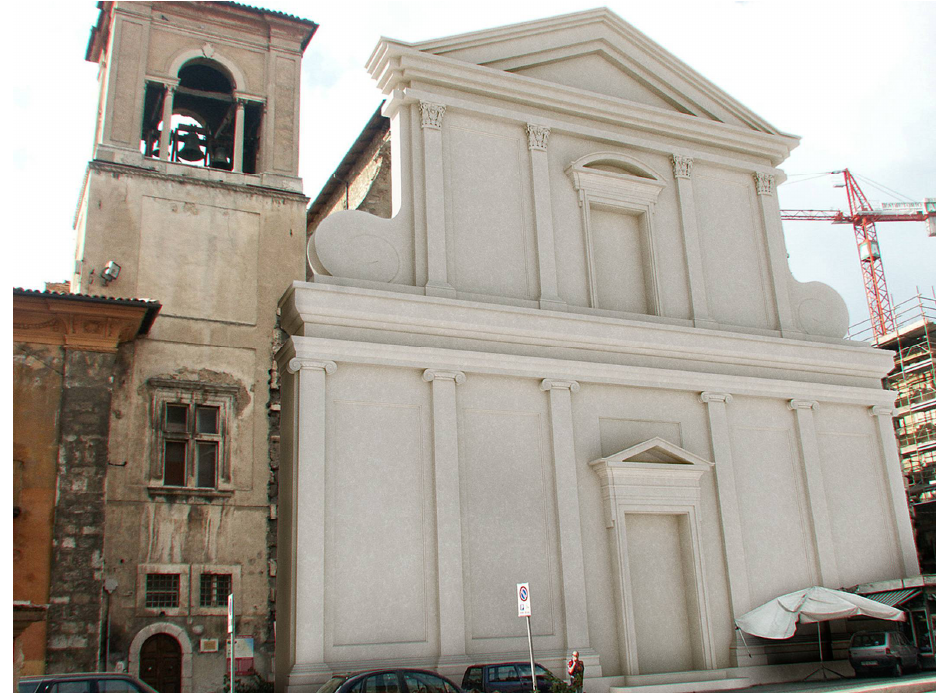
Figure 3. Virtual reconstruction of the facade never realized based on the survey, historical documents and design drawings.